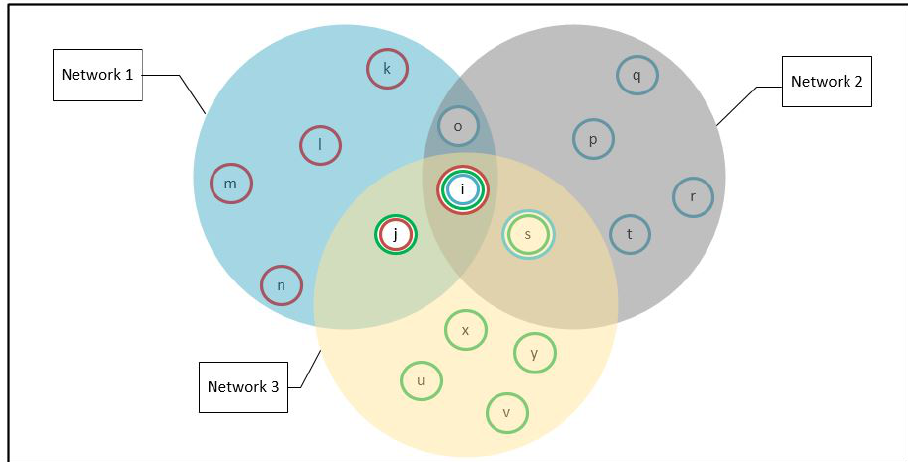
Figure 9. Neighbor lists of the adjacent